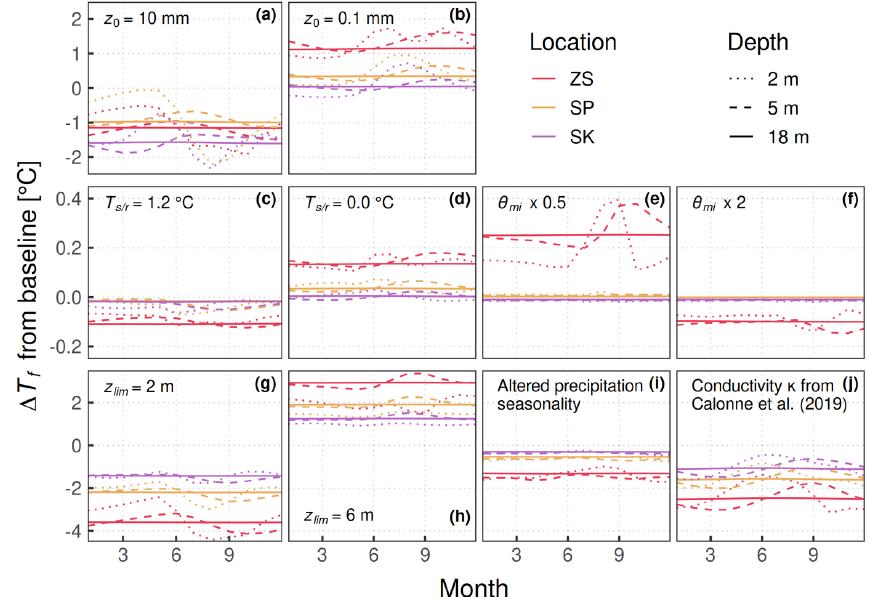
Figure B1. Modeled firn temperature deviations (cid:49)T f (2003–2018 means) by month, depth, and location, after single parameter perturbations. (a, b) Roughness length z 0 from 1 to 10mm and to 0.1mm. (c, d) Rain/snow temperature threshold T s / r from 0.6 to 1.2 ◦ C and to 0.0 ◦ C. (e, f) Residual saturation θ mi scaled by a factor of 0.5 and by a factor of 2 compared to Eq. (24). (g, h) Percolation depth parameter z lim from 4 to 2m and to 6m. (i) Precipitation amounts reduced by 50% in May–October and redistributed over the rest of the year. (j) Thermal conductivity parametrization changed from Sturm et al. (1997) to Calonne et al. (2019). The vertical scale is the same within each row. Locations are shown in Fig.